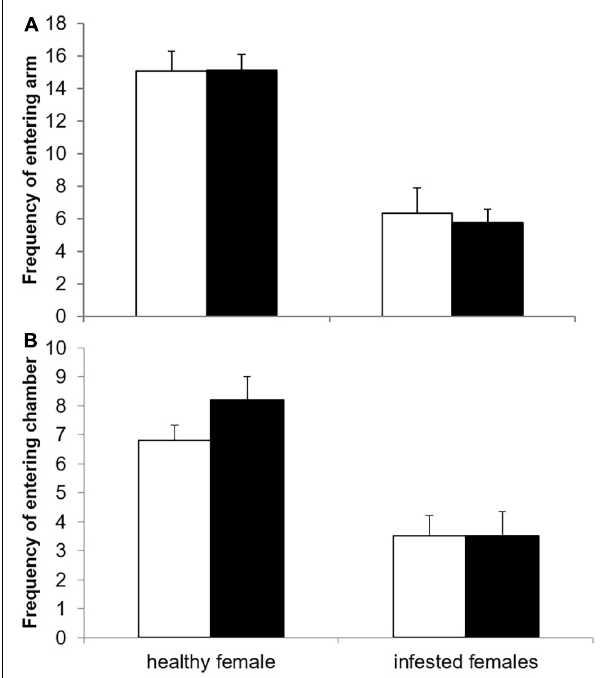
FIGURE 1 | Frequency of (A) entering the choice arm and (B) the choice chamber with the odor of a healthy (open bars) or infested male (solid bars) for healthy and infested female highveld